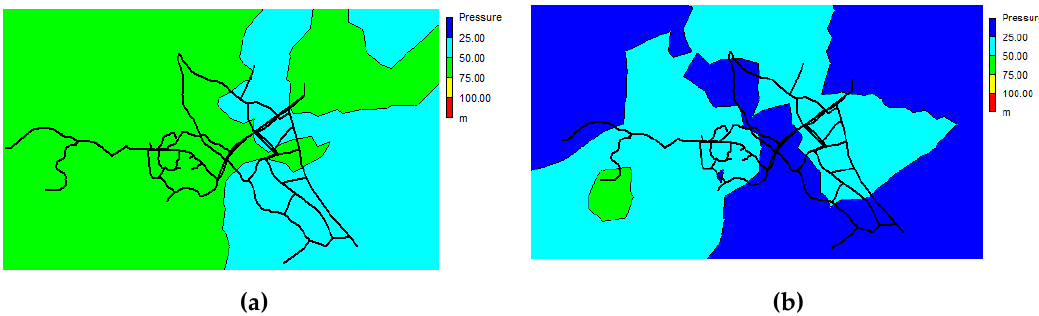
Figure 14. The comparisons of pressures without PAT ( a ) and with four PATs ( b ) at demand pattern 0.36.